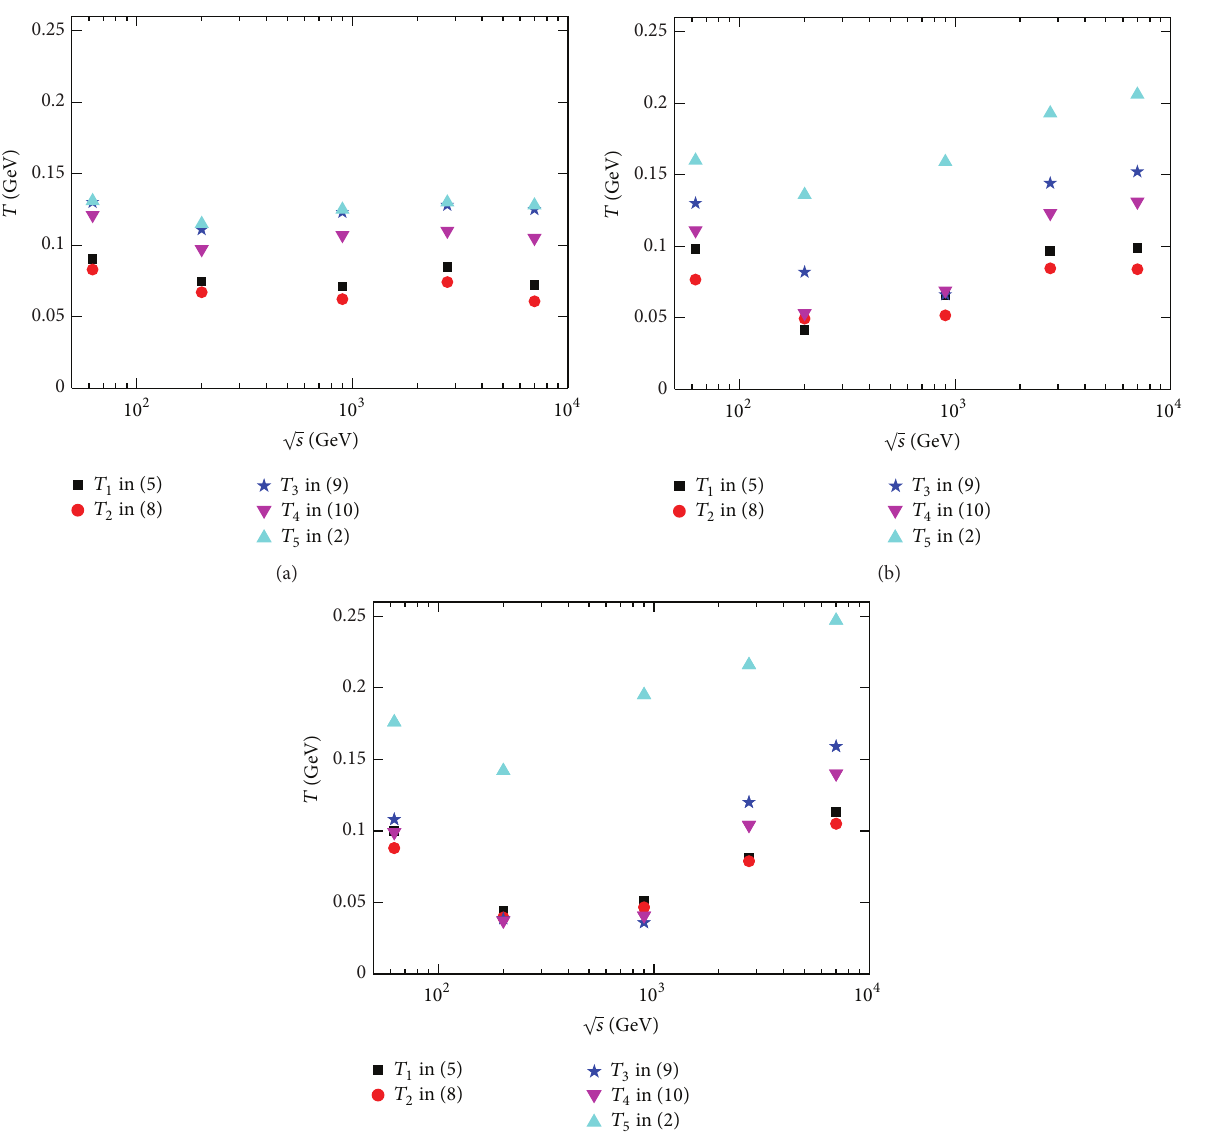
Figure 5: (Color online) temperature 𝑇 in the five distributions versus √ 𝑠 for (a) 𝜋 , (b) 𝐾 , and (c) 𝑝 in 𝑝 + 𝑝